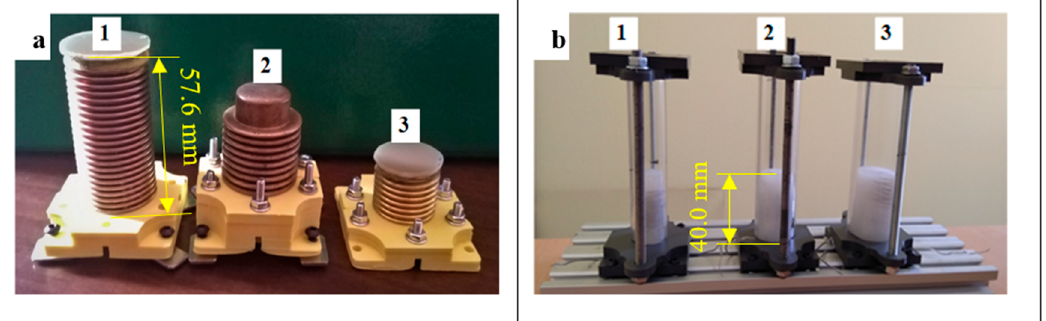
Figure 3. Photos of the bellow actuators investigated: ( a ) Bellow actuators: 1—big (B), 2—middle (M), 3—small (S); ( b ) tube actuators with equal initial length: 1—diameter of 15.5 mm, 2—diameter of 20.5 mm, 3—diameter of 25.0 mm.